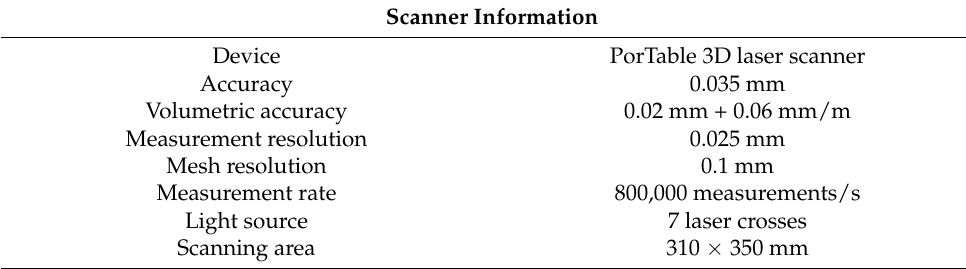
Table 2. The 3D scanner